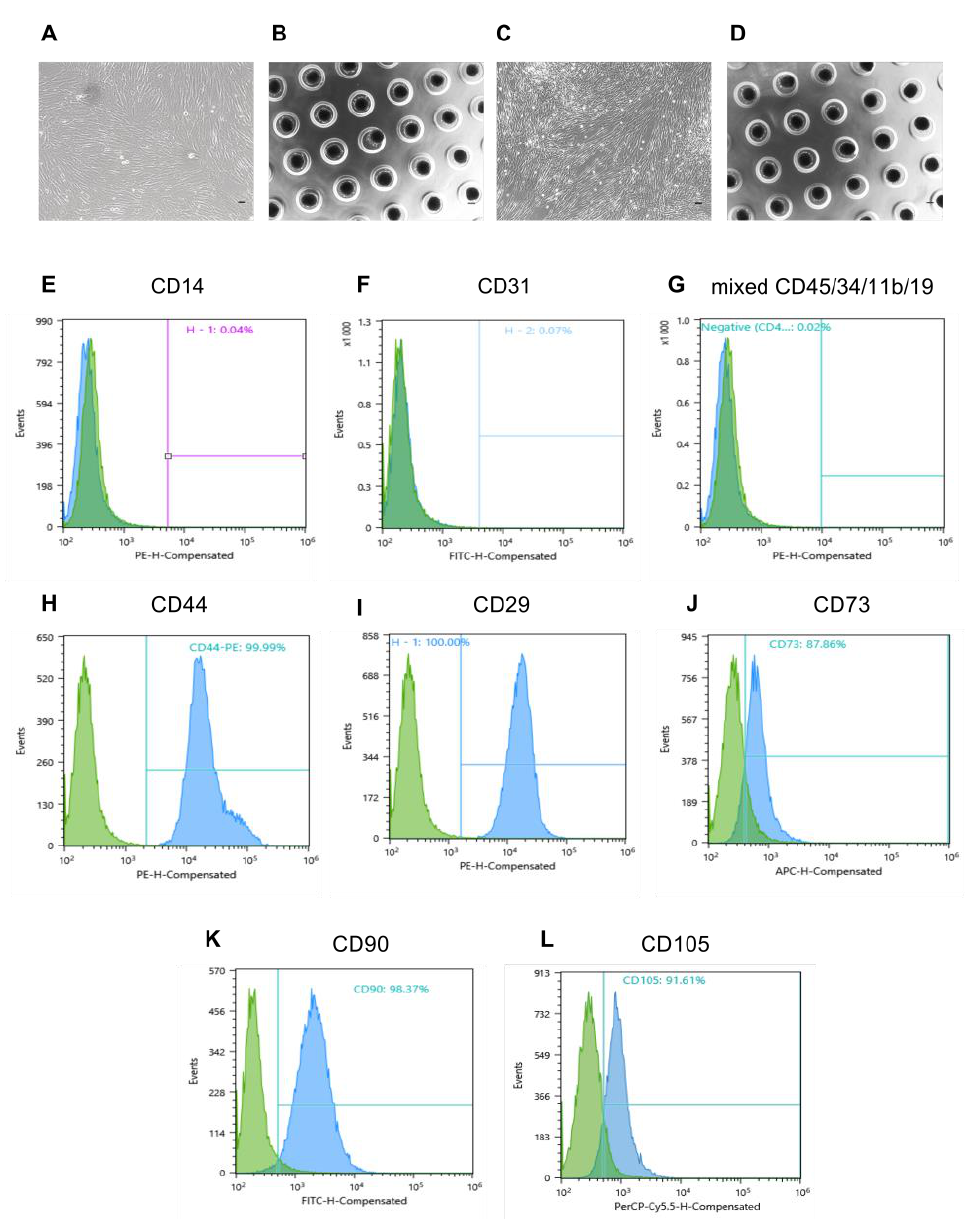
Figure 2. Morphology of MMSCs, lung fibroblasts and flow cytometric analysis of specific markers of MMSCs. ( A ) MMSCs at the third passage by day 3 in monolayer cultures. ( B ) MMSCs spheroids on day 3 in multiwell plates with agarose. ( C ) LFBs at the third passage by day 3 in monolayer cultures. ( D ) LFBs spheroids on days 3 in multiwell plates with agarose. Light phase contrast microscopy; scale bars = 100 µ m ( A , C ) and 200 µ m ( B , D ). ( E – G ) Negative endothelial and blood cell marker expression. ( H – L ) High expression of surface marker characteristic of MMSC population. MMSC, multipotent mesenchymal stromal cell; LFB, lung